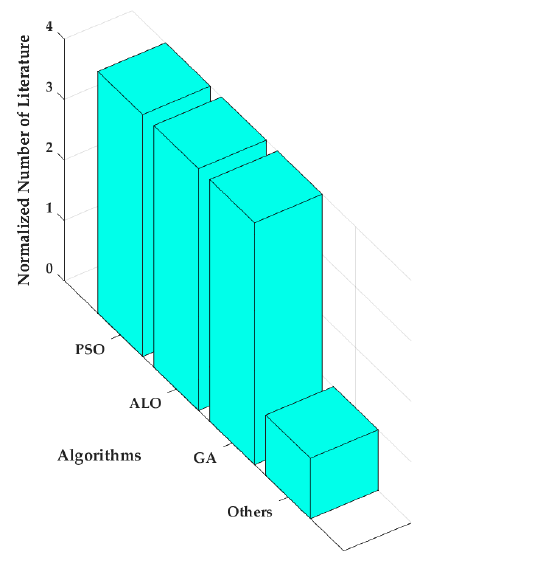
Table 2. Objective analysis of this review. Figure 8. ( a ) Survey related to algorithms involved in DN planning. ( b ) Survey related to objectives in DN planning.